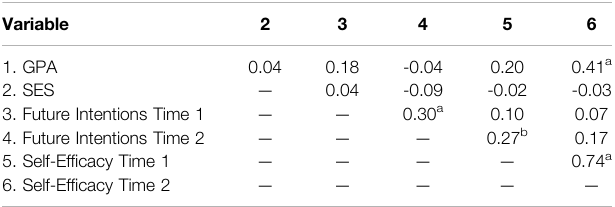
TABLE 3 | Study 2: Zero-Order Correlations (N (cid:1) 85). Variable